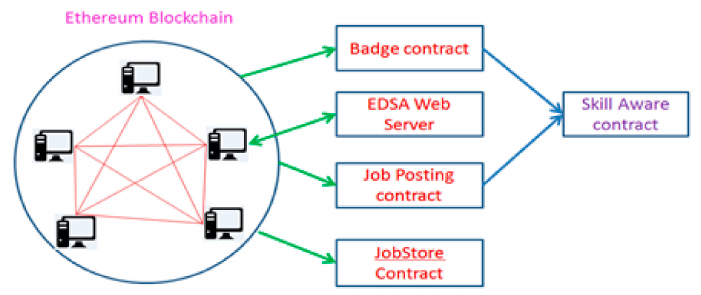
Figure 1. EDSA’s approach using